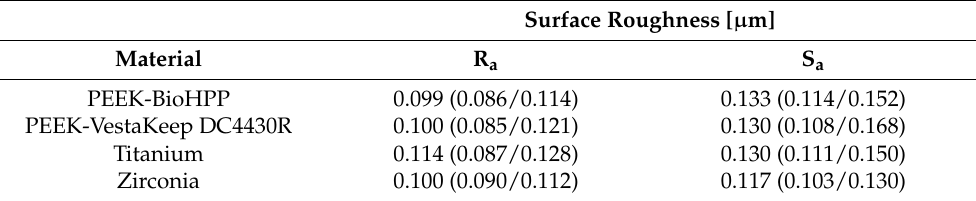
Table 1. The arithmetic mean roughness (R a ) and the area-related mean arithmetic height (S a ) of the test materials (medians and 25/75 percentiles); no significant differences were